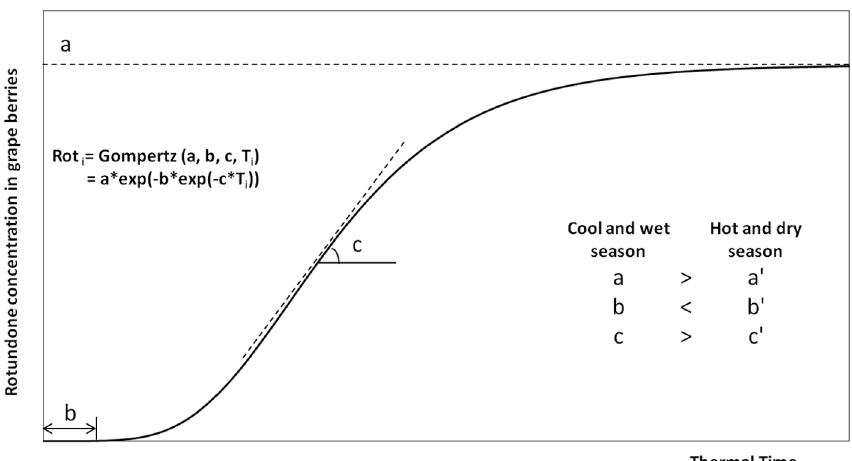
Fig 2. Rotundone accumulation model (RAM) describing the accumulation dynamics of rotundone in grape berries from veraison to harvest using the Gompertz function. In the Gompertz function, Rot i = Gompertz (a, b, c, T i ), Rot i is the rotundone concentration of grape berries at the time T i , parameter a, b and c represents plateau, displacement along time axis and curve growth rate, respectively. Cool and wet seasons are assumed to have higher a, c and lower b compared to hot and dry seasons (a ’ , b ’ and c ’